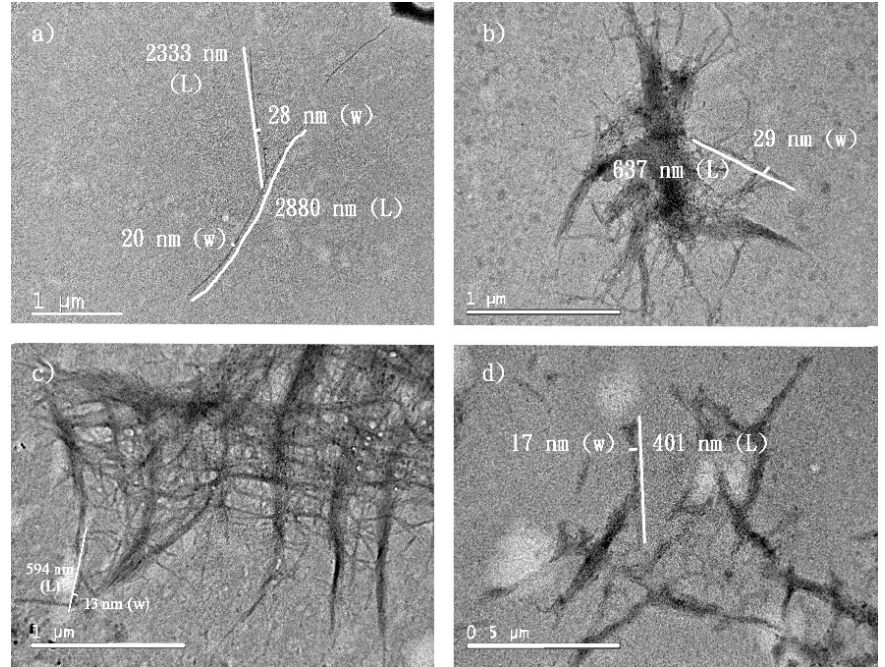
Figure 7. P-CNCs prepared with 46% sulfuric acid at 45 °C for ( a ) 0.5 h, ( b ) 1 h, and ( c ) 2 h and at 65 °C for ( d ) 2 h.